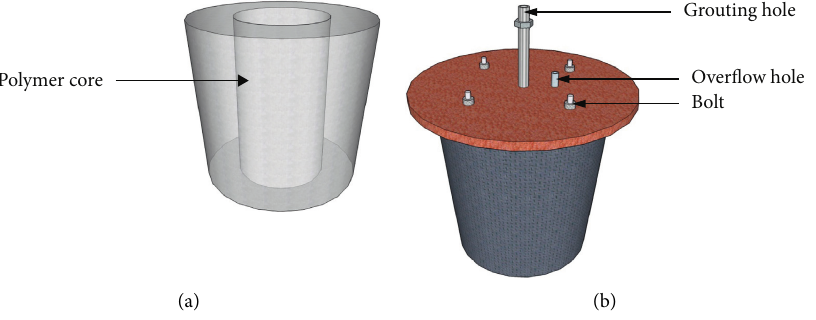
Figure 1: (a) Test piece schematic. (b) Steel Table 1: The parameters related to specimens.